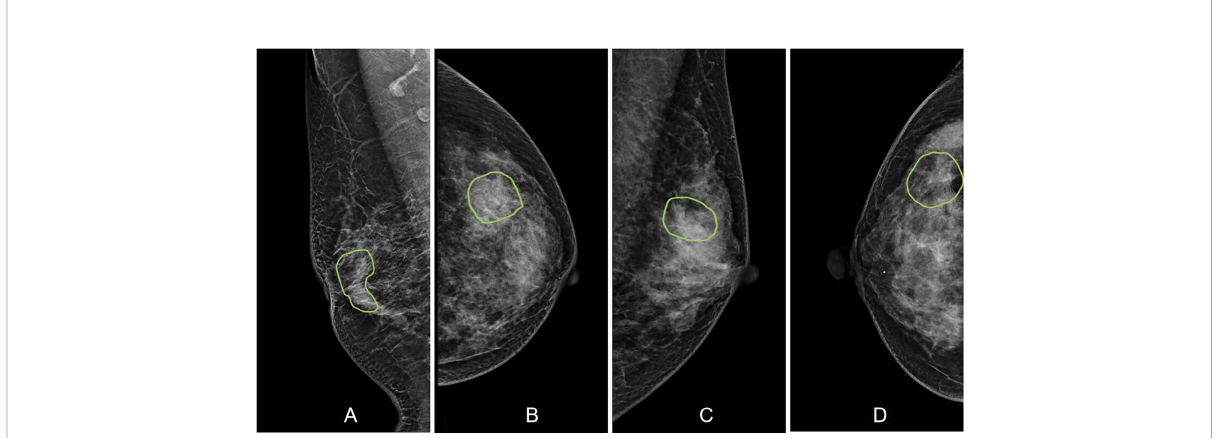
FIGURE 3 Case examples showing the atypical architectural distortion. (A) The RMLO view of a 57-year-old patient diagnosed with invasive ductal cancer. The BI-RADS score is 5. The radiomics score of the combined model is 0.66, true-positive. (B) The LCC view of a 39-year-old patient diagnosed with ductal carcinoma in situ . The BI-RADS score is 5. The radiomics score of the combined model is 0.61, true-positive. (C) The LMLO view of a 39-year-old patient diagnosed with papilloma. The BI-RADS score is 4B. The radiomics score of the combined model is 0.48, true-negative. (D) The RCC view of a 52-year-old patient diagnosed with adenosis. The BI-RADS score is 3. The radiomics score of the combined model is 0.41,